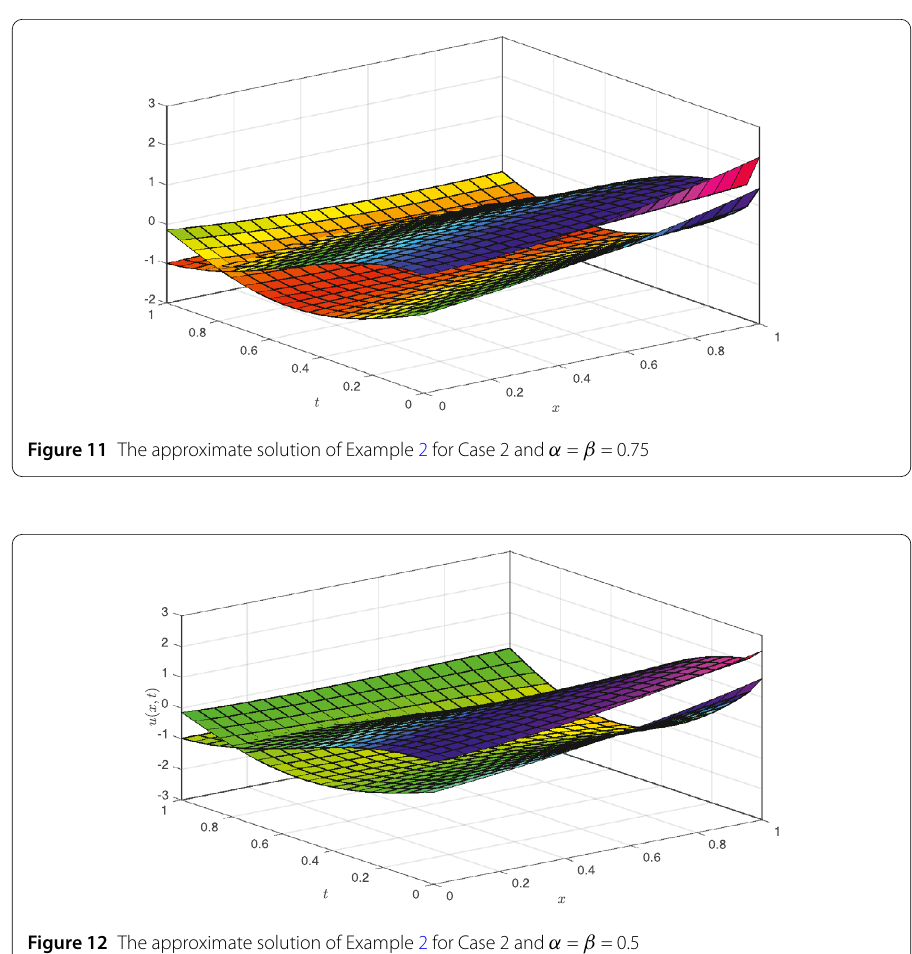
Figure 12 The approximate solution of Example 2 for Case 2 and α = β =